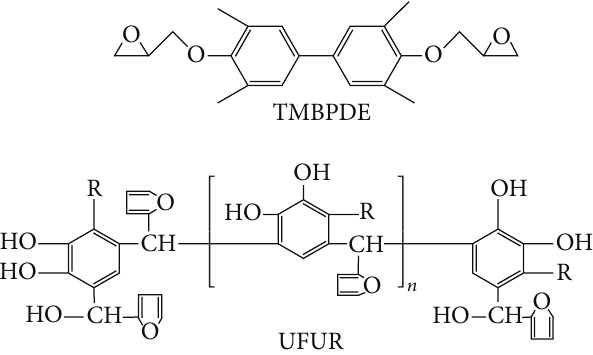
Figure 1: The chemical structures of TMBPDE and